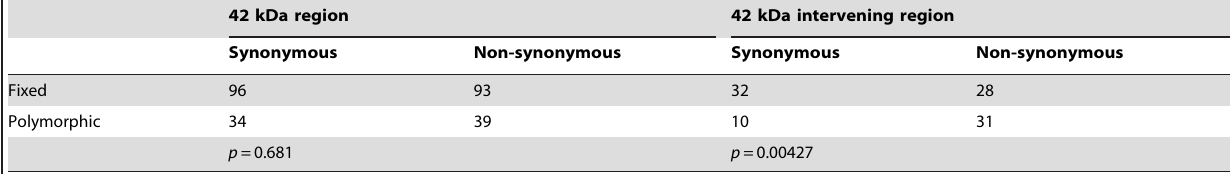
Table 2. McDonald-Kreitman test for selection in pvmsp-1 .